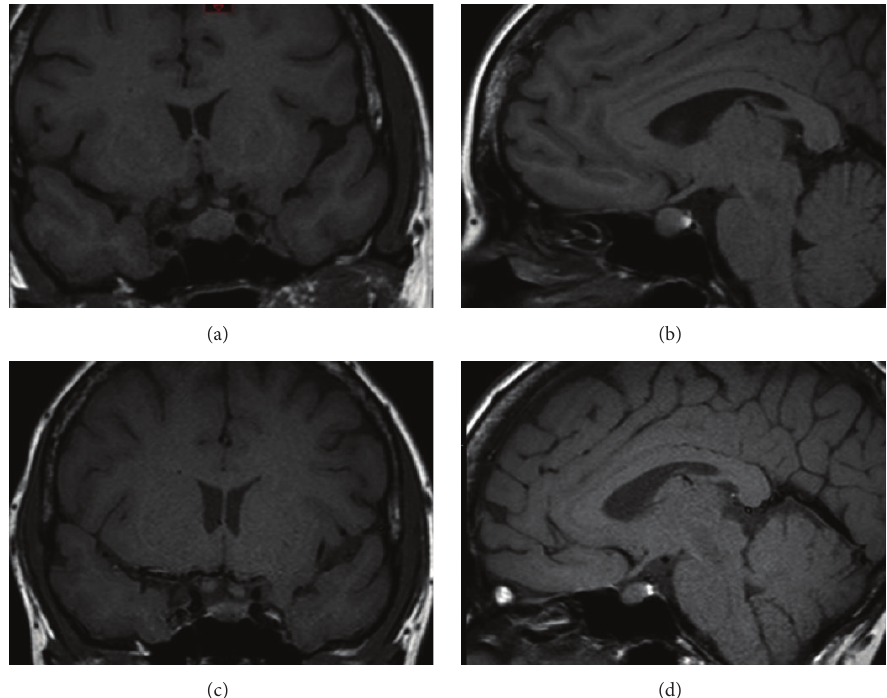
Figure 2: Sella MRI images showing pituitary enlargement at presentation (a, b) and 4 months after embolization (c, d), showing significant reduction in size.